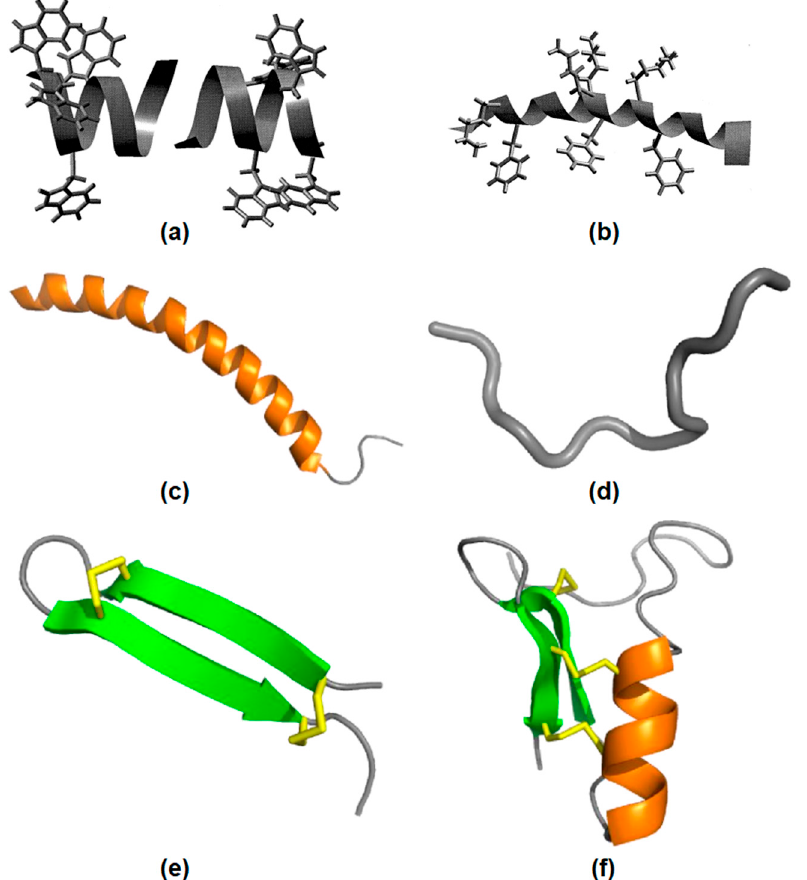
Figure 2. AMPs structural features. ( a ) The gramicidin A structure in membranes. ( b ) The magainin structure in micelles, adapted from [57], Copyright 1999, with permission from Elsevier. ( c ) The LL − 37 peptide structure in micelles. ( d ) The indolicidin structure. ( e ) The gomesin structure stabilized by disulfide bonds. ( f ) The insect CS αβ− defensin phormicin, Adapted with permission from [58]. Copyright 2019 Elsevier.